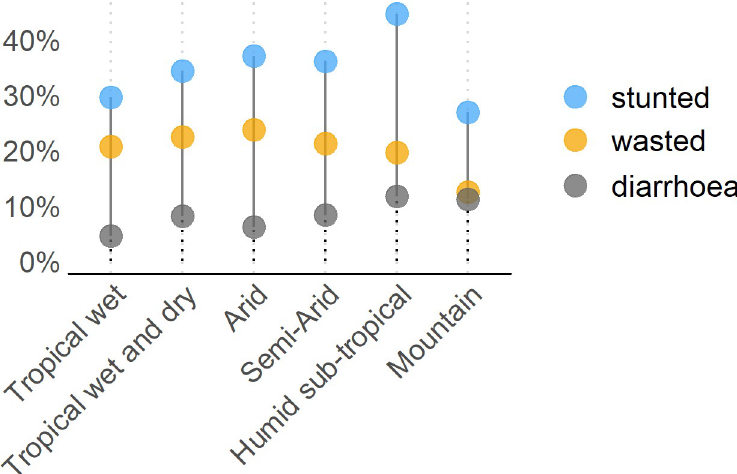
Fig 6. Share of stunted and wasted children, and children with diarrhoea aged 0–5 by climate zone. Source: Own calculations based on DHS India 2015–16. Notes: Sampling weights applied in the calculation of stunting, wasting and diarrhoeal prevalence. Climate zones based on Ko¨ppen-Geiger climate classification; see text for details.